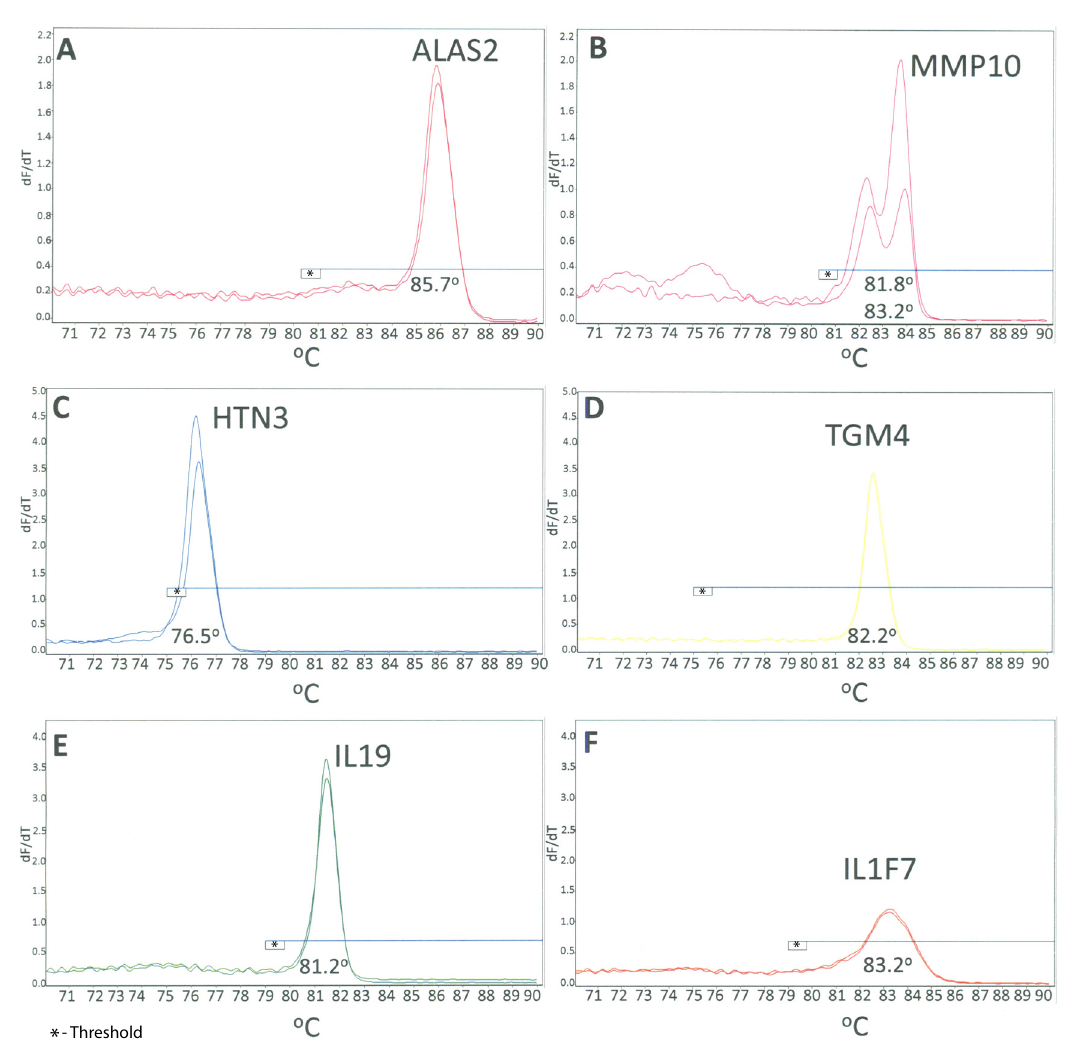
Figure 1. Singleplex HRM body fluid assays. High resolution derivative melt curve plots for individual body fluid specific markers: A ) ALAS2 (blood); B ) MMP10 (menstrual blood); C ) HTN3 (saliva); D ) TGM4 (semen); E ) IL19 (vaginal secretions); F ) IL1F7 (skin). The plots from two different donors are shown for each marker. The x-axis represents the temperature and the y-axis indicates the first derivative of the change of fluorescence with temperature (-dF/dT). The average T (°C) for each marker is displayed. The horizontal line on each plot represents the m analysis